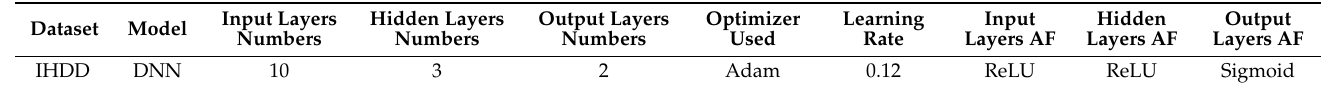
Table 5. Samples from pre-processed IHDD